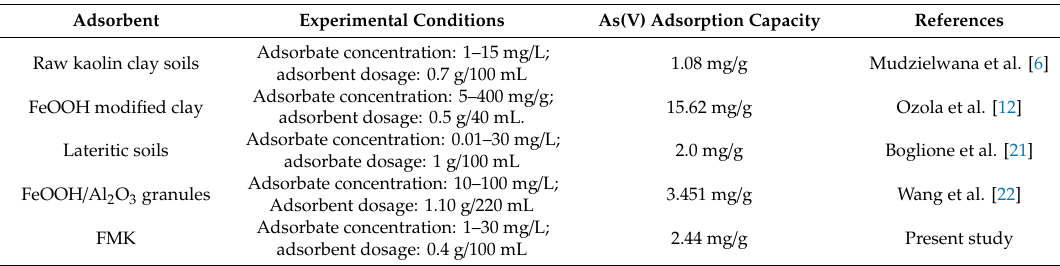
Table 7. Comparison with other